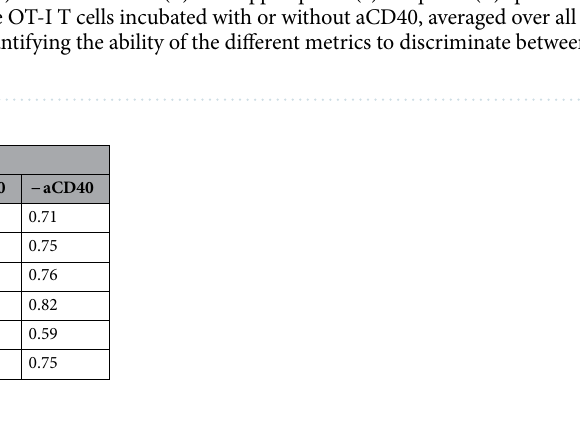
Table 2. Summary of OT-I T cell